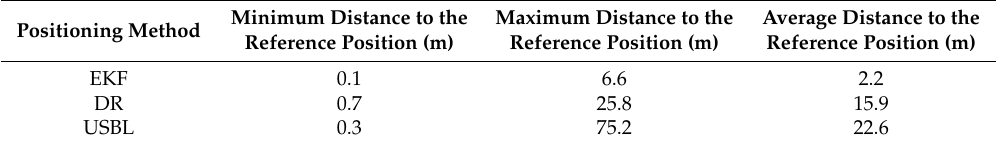
Table 1. Statistical parameters of positioning errors by EKF and DR methods and the USBL system (single passage).